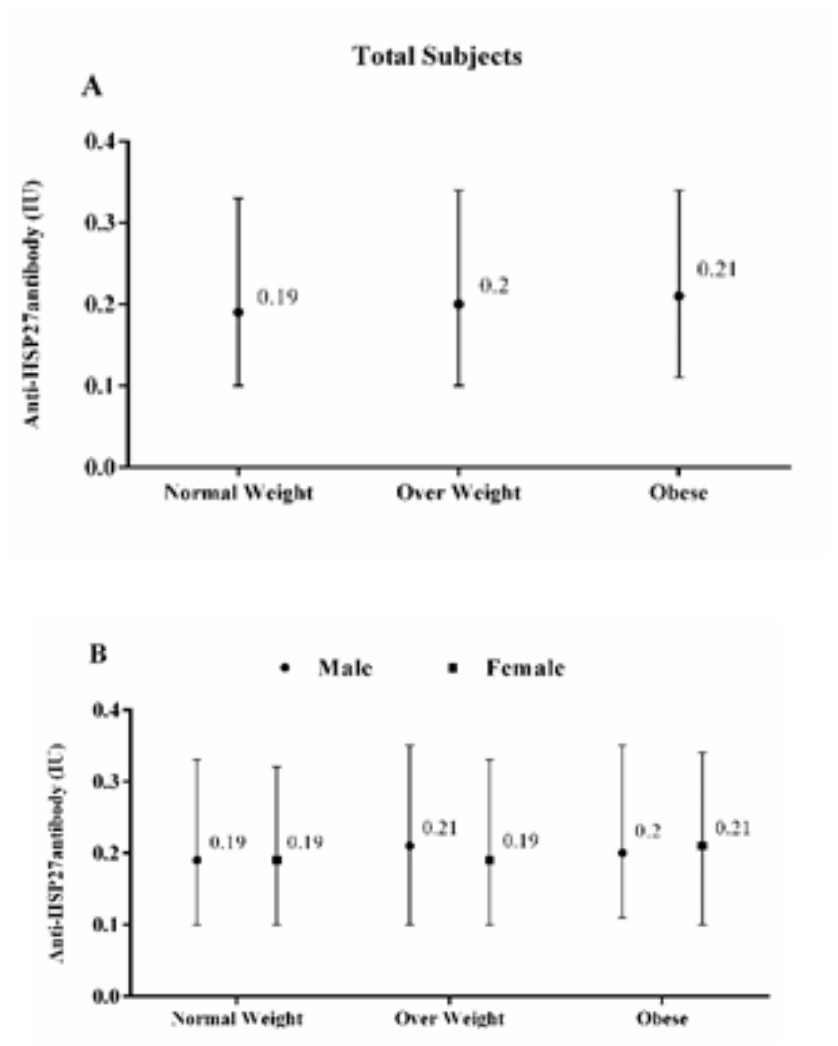
Figure 1. Levels of anti-HSP-27 antibody; A: among total individuals, B: according to Male and Female. Data presented as median (inter-quartile range). Normal-weight, over-weight and obesity were defined as BMI<25, 25≤BMI <30 and BMI ≥30 respectively .